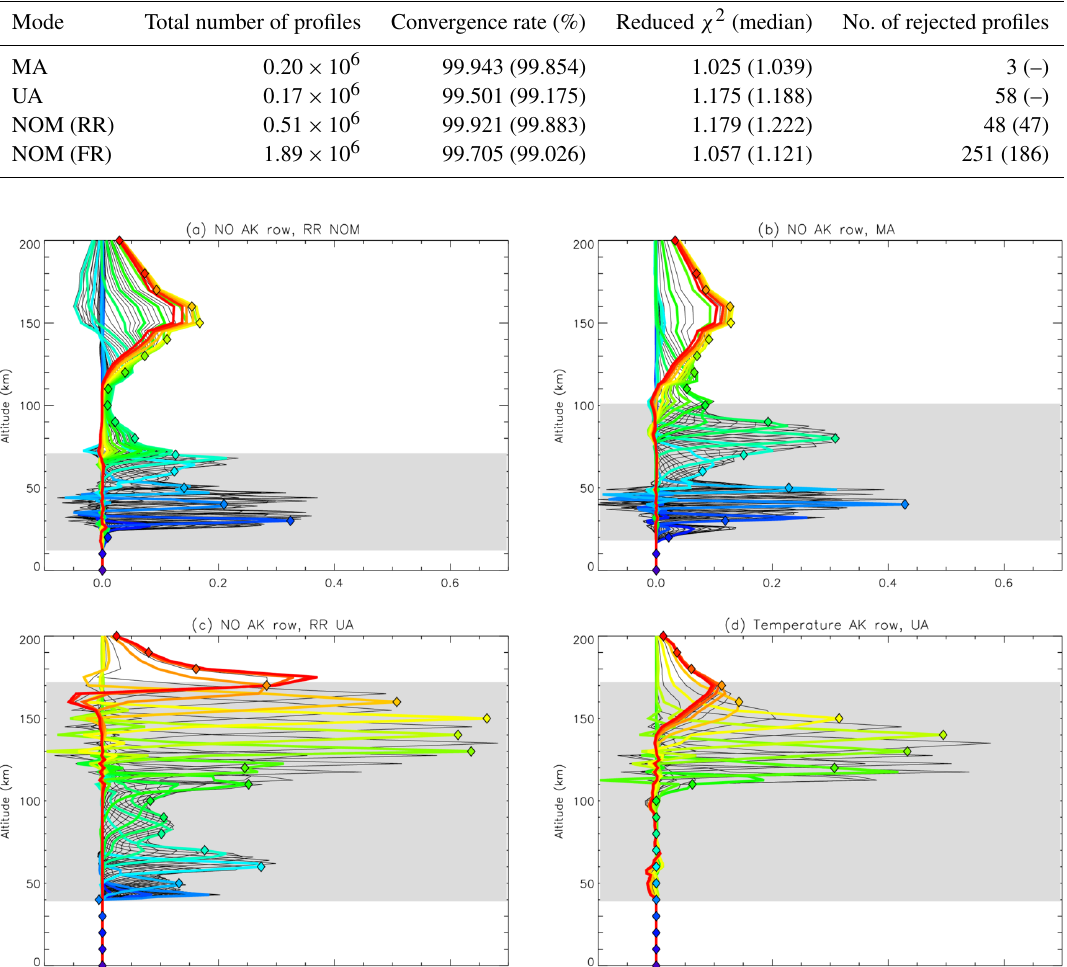
Figure 1. Example averaging kernel rows of the retrieved NO from (a) NOM RR measurements, (b) MA measurements, (c) UA mea- surements, and (d) the retrieved temperature from UA measurements. Rows corresponding to profile altitudes of 0, 10, 20, ... 200km are highlighted with colored lines. The corresponding averaging kernel diagonal elements are indicated by symbols. The vertical scan range of the respective measurements is indicated by grey shading. All averaging kernels shown belong to daytime measurements taken in January 2012 at latitudes around 55 ◦